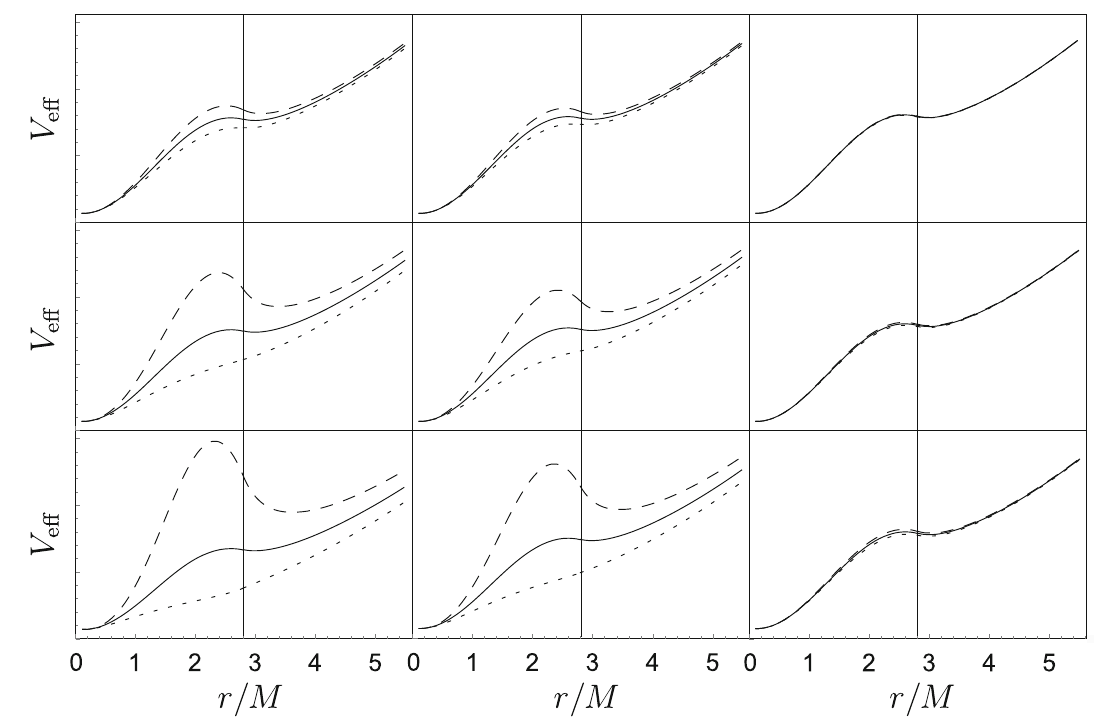
Fig. 8 Effective potentials for objects with compactness R / M = 2 . 8 for several values of j and θ . The solid lines are effective potentials for non-rotating configurations. The dotted and dashed lines denote effective potentials for co-rotating and counter-rotating null geodesics